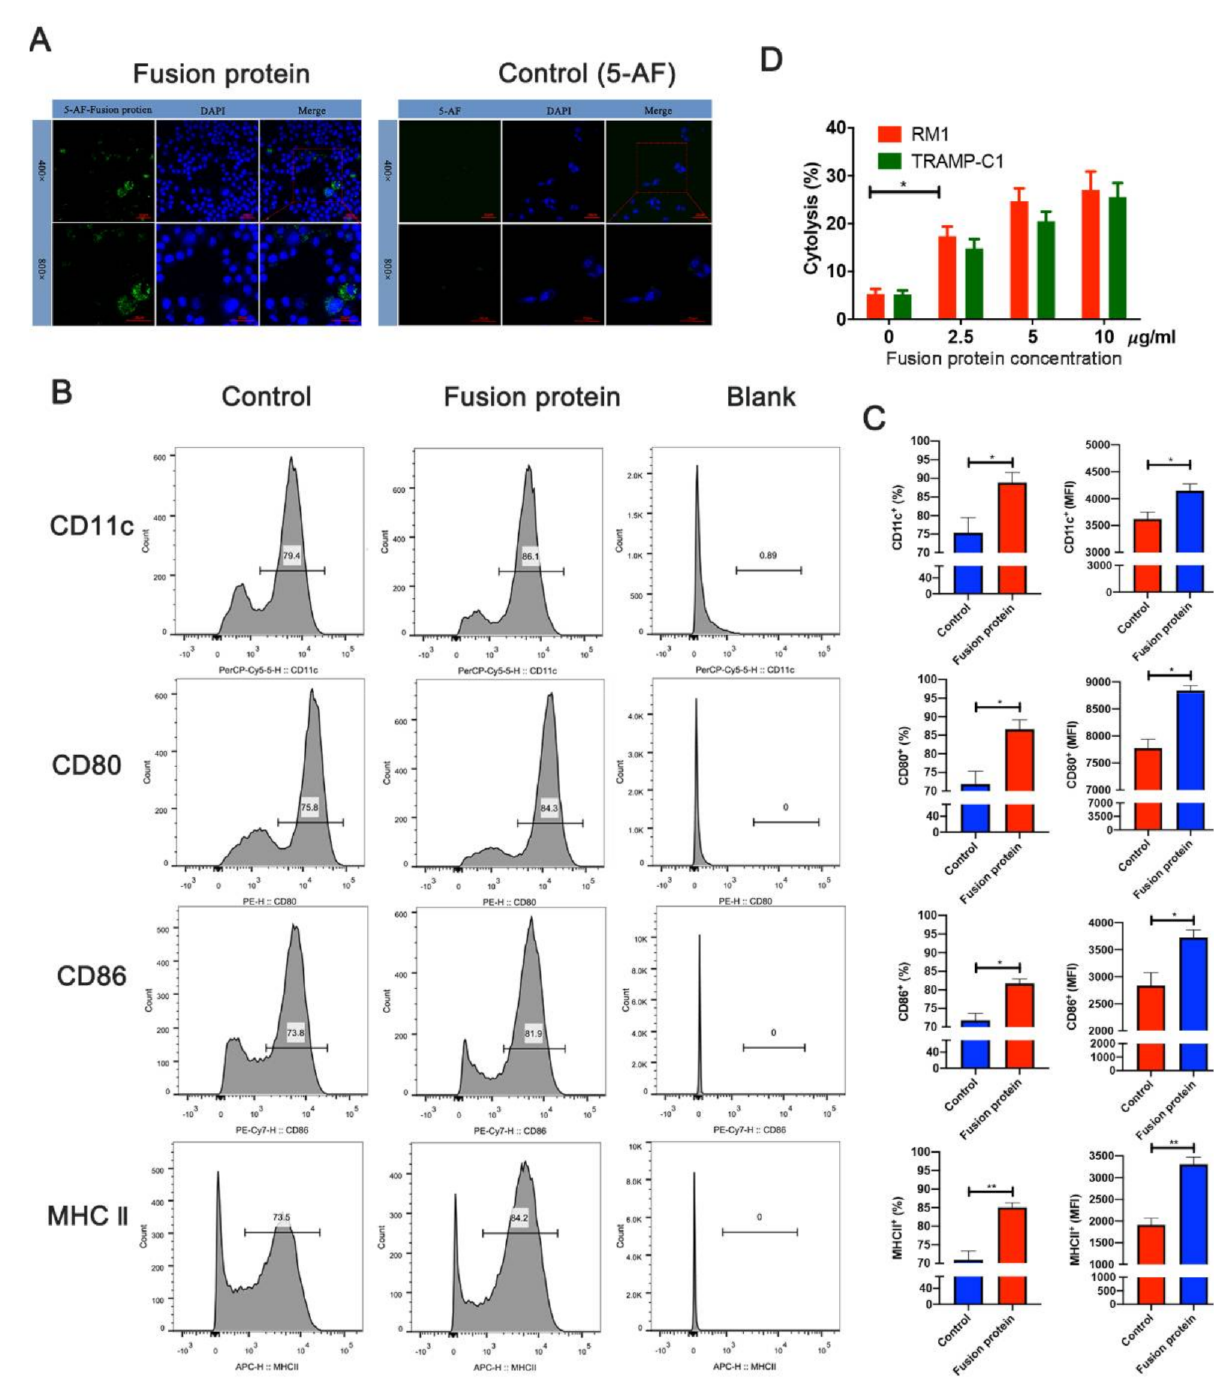
Figure 3. Fusion protein vaccine activates DCs and elicits efficient cytotoxic T lymphocyte (CTL) responses in vitro. ( A ) DCs taking up the fusion protein, which was labeled with 5-aminofluorescein (5-AF). ( B ) Flow cytometry analysis of protein markers in DCs. ( C ) Quantified results of the flow cytometric analysis. MFI, mean fluorescence intensity. ( D ) The lactate dehydrogenase-releasing cytotoxicity assay (LDH) was performed to determine the cytotoxic efficiency of effector T cells against RM1 and TRAMP-C1 cells at different concentrations of the fusion protein. * p < 0.05; ** p <